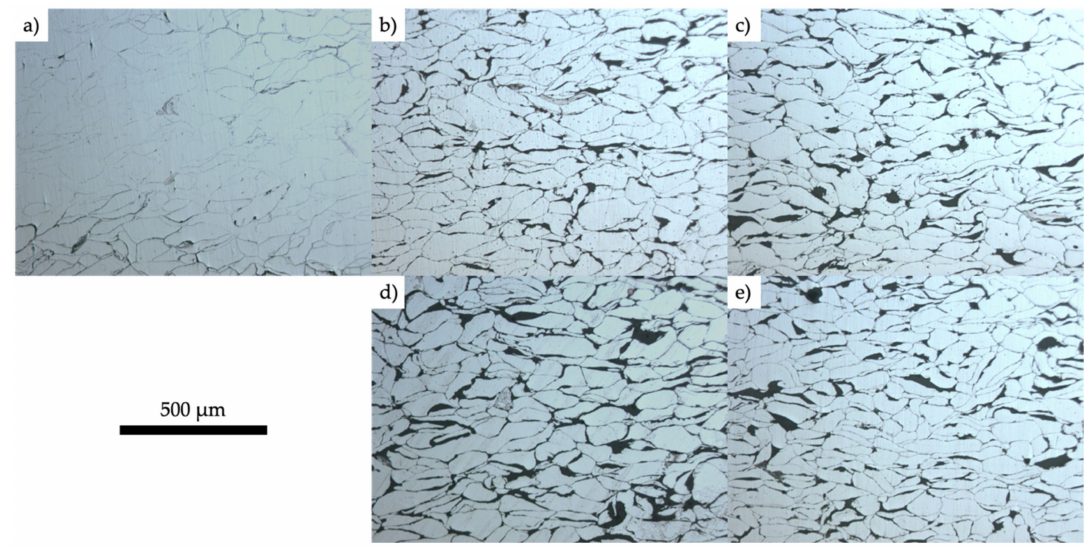
Figure 4. Optical micrographs of ( a ) Mg–0HAP, ( b ) Mg–8HAP, ( c ) Mg–10HAP, ( d ) Mg–12HAP, and ( e ) Mg–10HAP106 after sintering using SPS system.